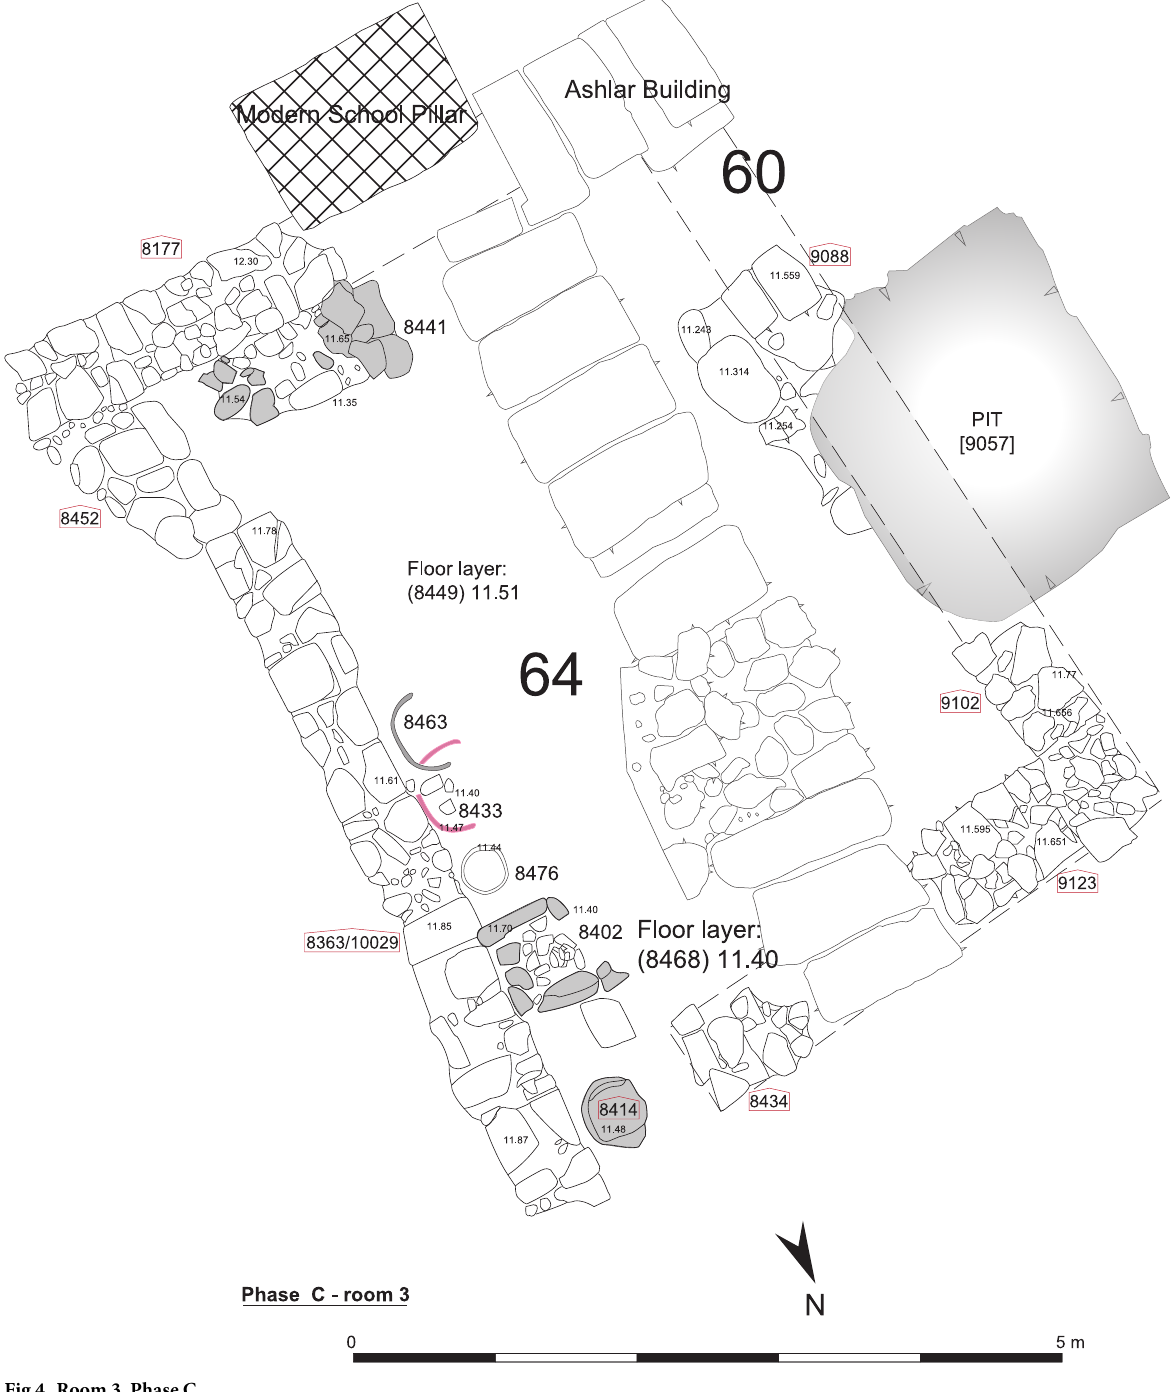
Fig 4. Room 3, Phase